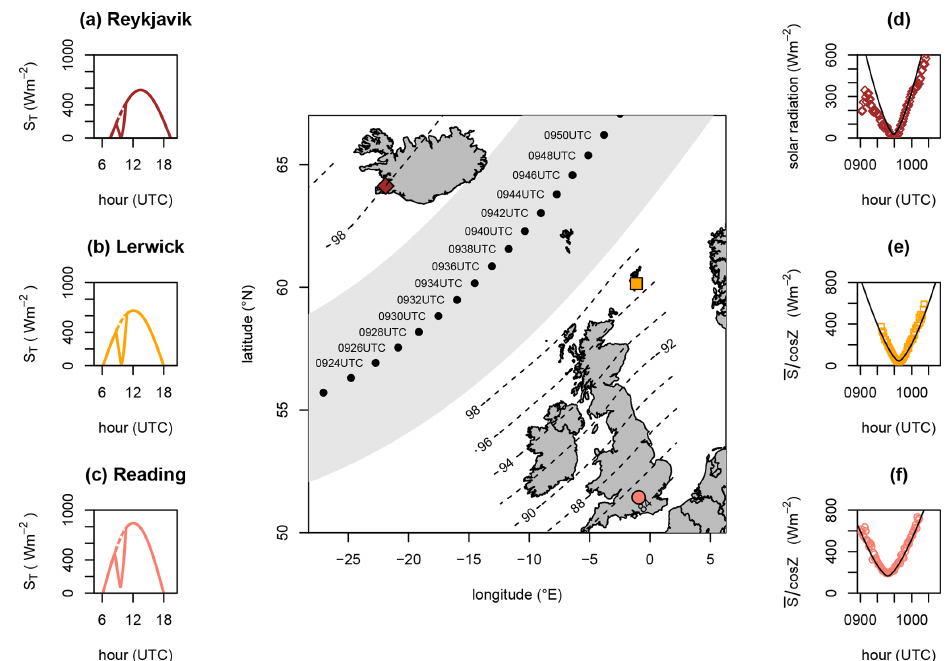
Figure 16. Solar radiation variations during the 20 March 2015 eclipse, predicted for (a) Reykjavik, (b) Lerwick and (c) Reading, and (d– f) measured by radiosonde above the same three sites, respectively. The central panel shows the region of totality (grey band) with timings and the partial eclipse fractions. Reykjavik (diamond), Lerwick (square) and Reading (circle) are marked. (Adapted from Harrison et al.,